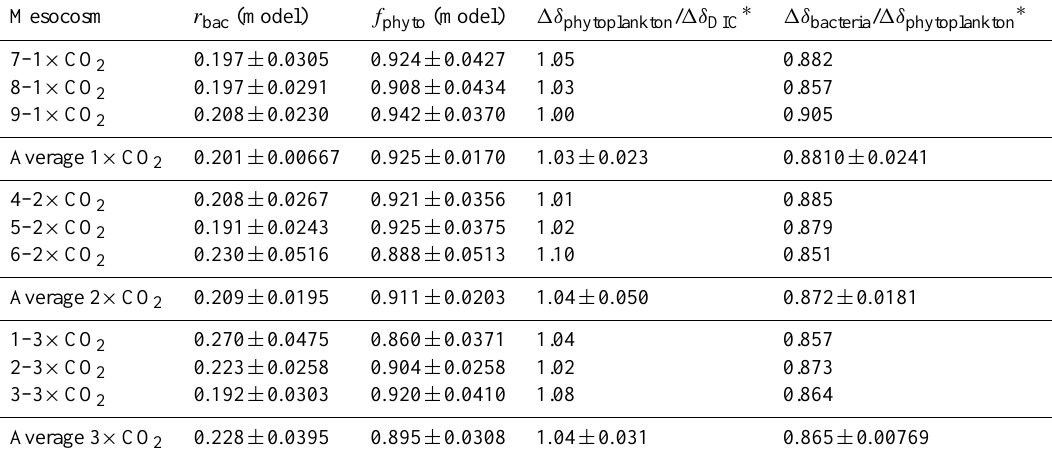
Table 2. Model parameters and steady-state ratios for each mesocosm ± standard deviation.